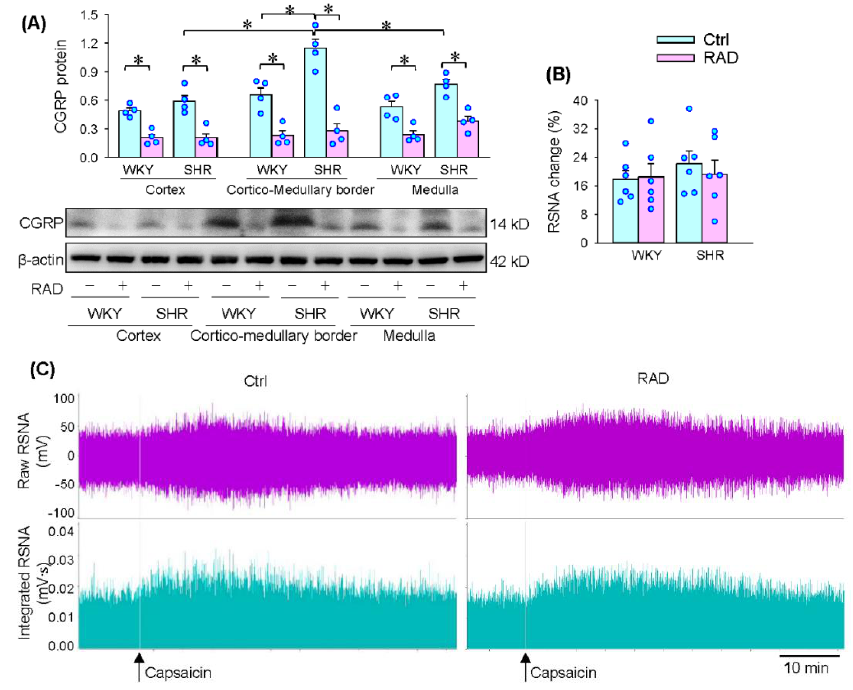
Figure 1. Identification of renal afferent denervation (RAD) in WKY and SHR. ( A ) CGRP protein expression in the cortex, cortico-medullary border and medulla of the kidney, which is used as a marker of afferent innervation of the kidney. ( B ) RSNA response to the infusion of capsaicin to the inguinal white adipose tissue, which is used to confirm the intact renal efferent activity. ( C ) Representative recordings showing the RSNA response to the infusion of capsaicin to the inguinal white adipose tissue in SHR. Values are mean ± SE. Two- way ANOVA followed by Bonferroni’s post hoc analysis were used for comparisons. * p < 0.05. n = 4 for each group in ( A ). n = 6 for each group in ( B ).